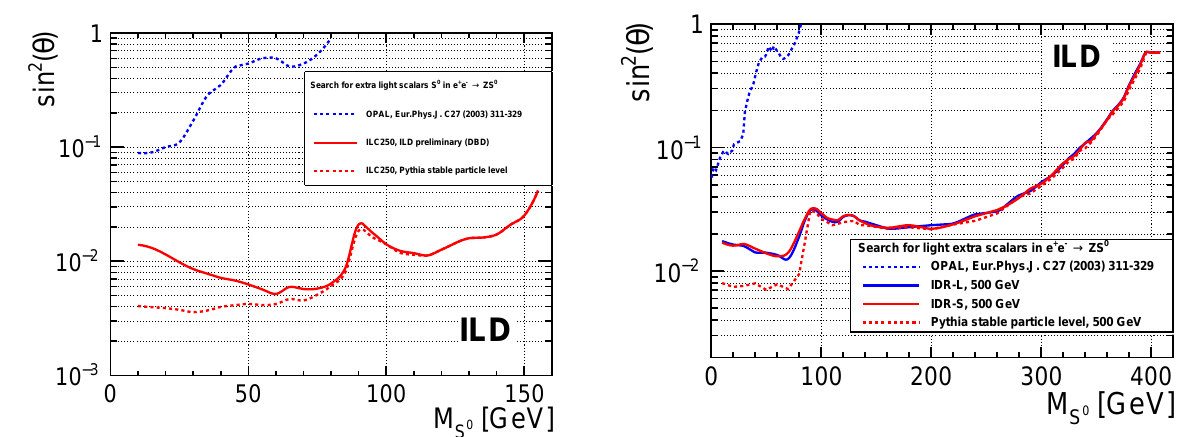
Figure 11. Upper bounds on the mixing angle for the model discussed in [41], in a comparison of different detector concepts and using the recoil method.